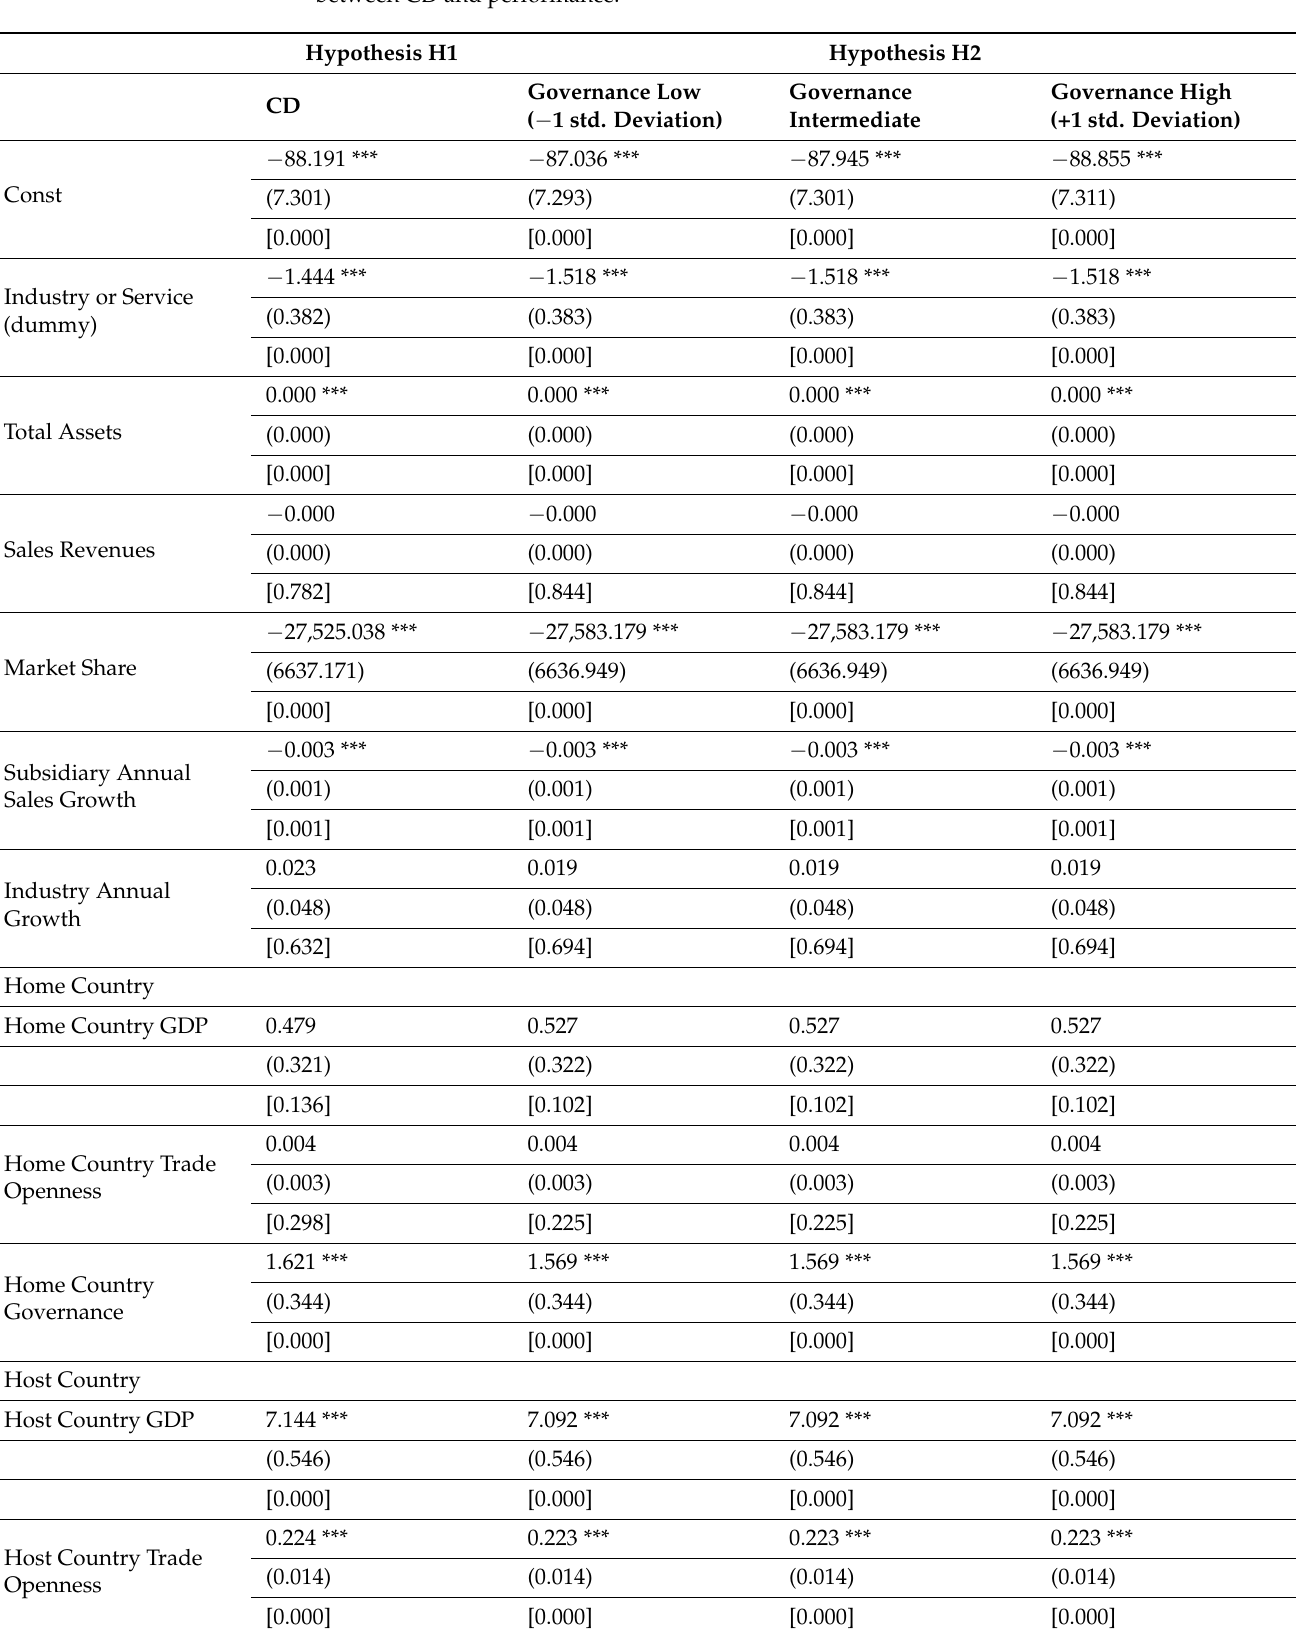
Table 1. The effect of CD and the moderating effects of host country governance on the relation between CD and